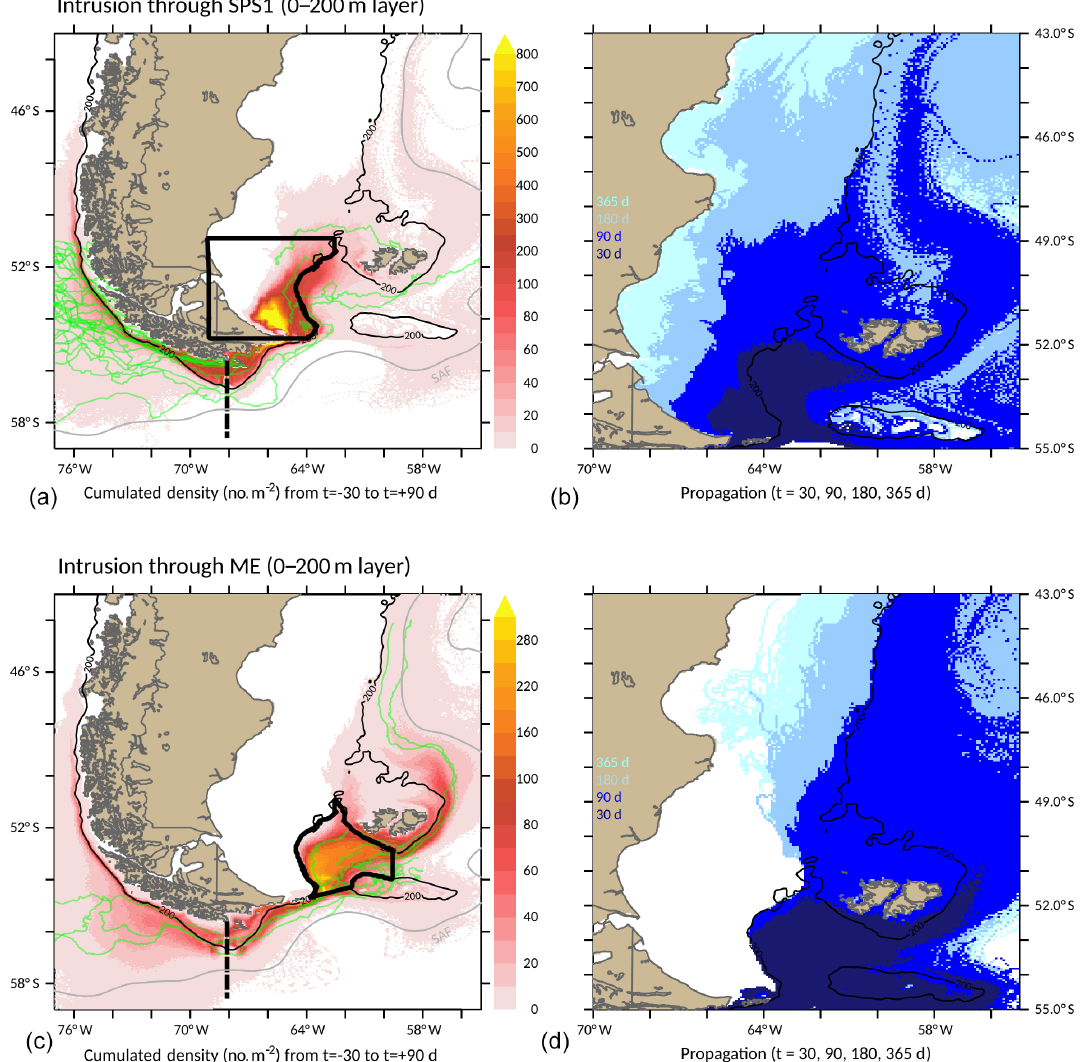
Figure 7. Pathways of the monthly release of particles at Cape Horn (68.1 ◦ W, from 58.5 ◦ S to the coast) on the 0–200m layer. Arrival at the Atlantic section through (a, b) SPS1 and (c, d) the Malvinas Embayment. Simulations are run backward for 30d and forward for up to 365d. (a, c) Cumulative square-meter density (number of particles per square meter simulations of 90d. The drifter trajectories towards each area are shown in green. The dotted line at 68.1 ◦ W shows the release section, and the black area shows the SPS1 and Malvinas Embayment areas, respectively. (b, d) Color shading shows the propagation of the advected particles after 30, 90, 180, and 365d from dark to light blue.